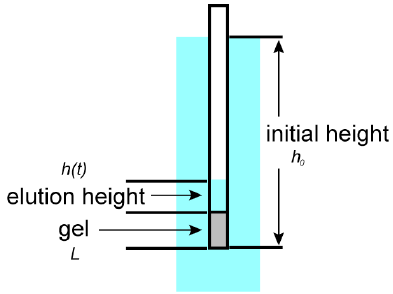
Figure 3. The setup for the friction measurements in the present